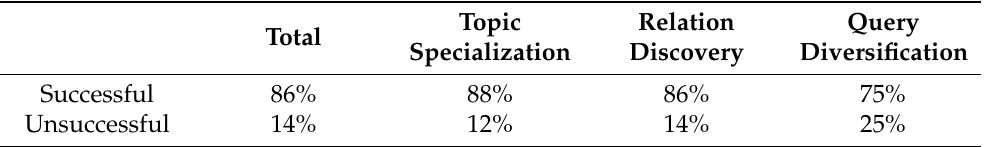
Table 1. Distribution of “successful” and “unsuccessful” searches.